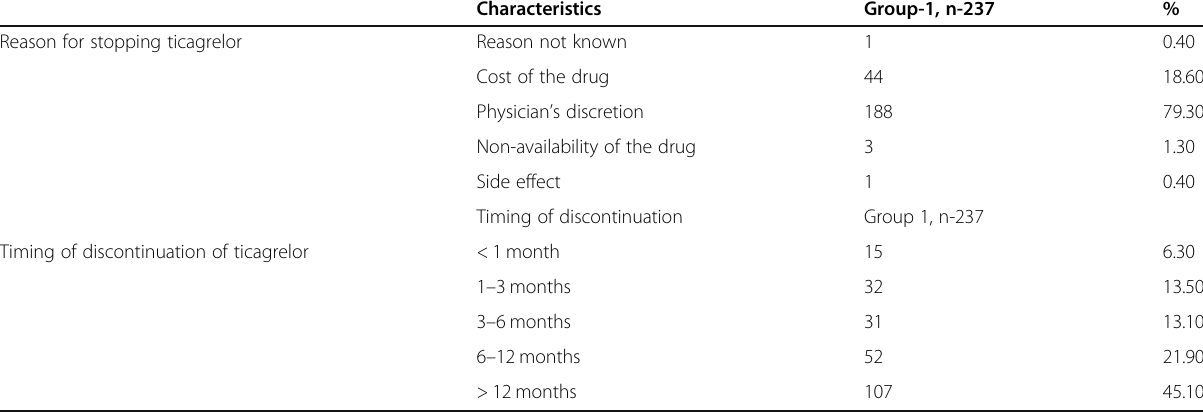
Characteristics